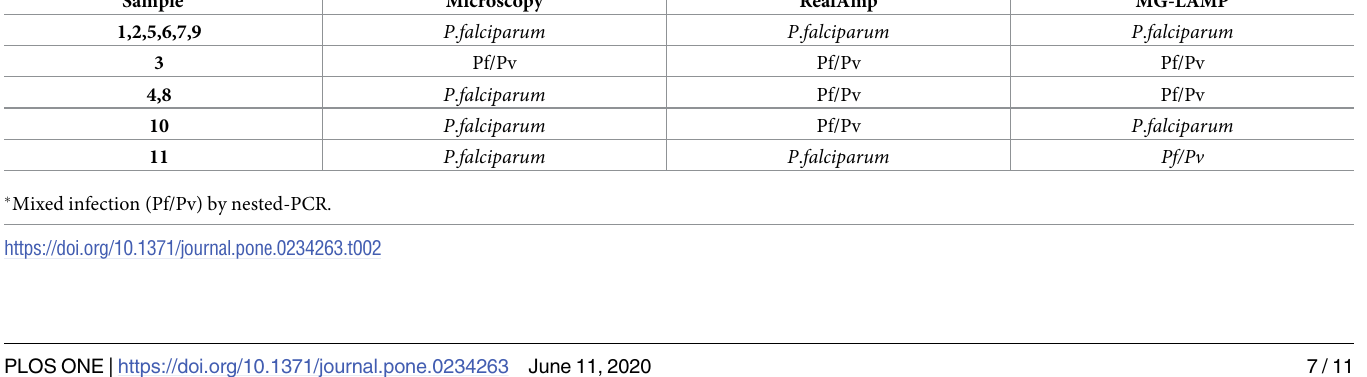
Table 2. Comparison of results of mixed infections (Pf/Pv) performed by each methodology. Sample